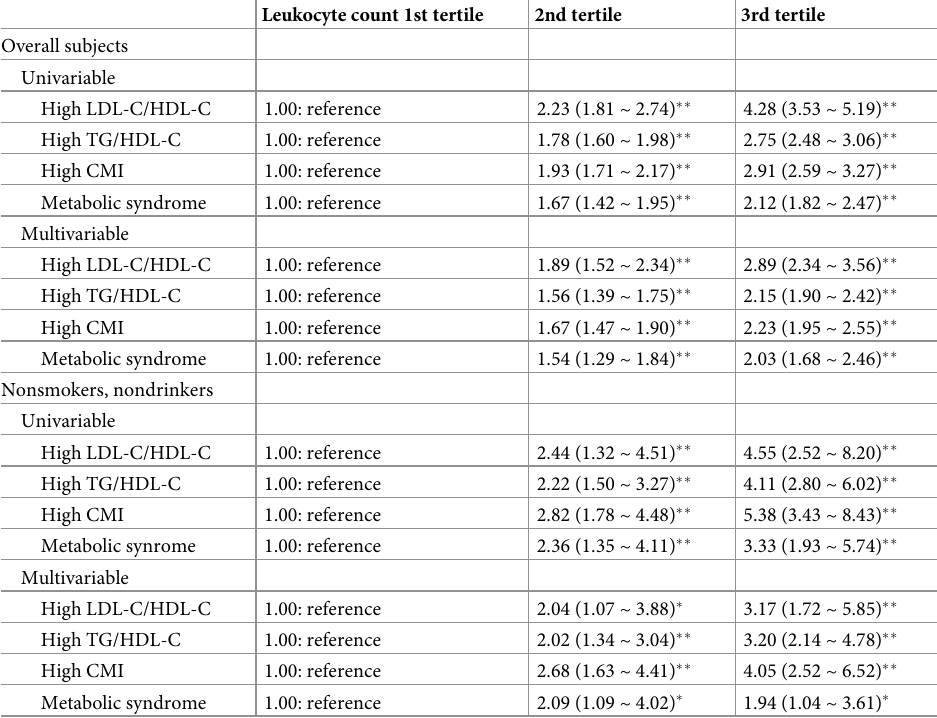
Table 6. Odds ratios for each cardiometabolic risk factor in the 2nd and 3rd tertile groups vs. the 1st tertile group of leukocyte count.